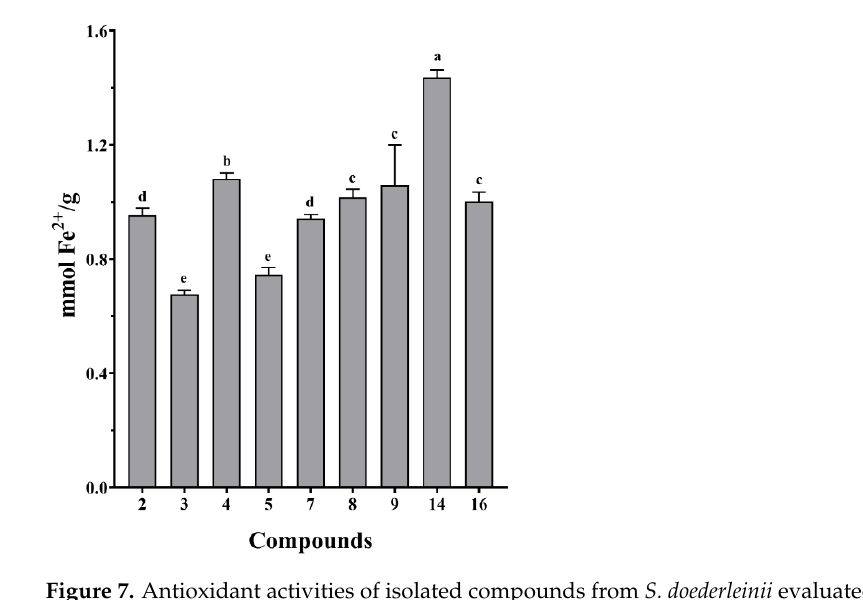
Figure 7. Antioxidant activities of isolated compounds from S. doederleinii evaluated by FRAP assay. The data were expressed as means ± SD ( n = 3). The mean values denoted with letters (a–e) are signif- icantly different at a level of p < 0.05 ( n = 3) by one-way ANOVA DMRT.